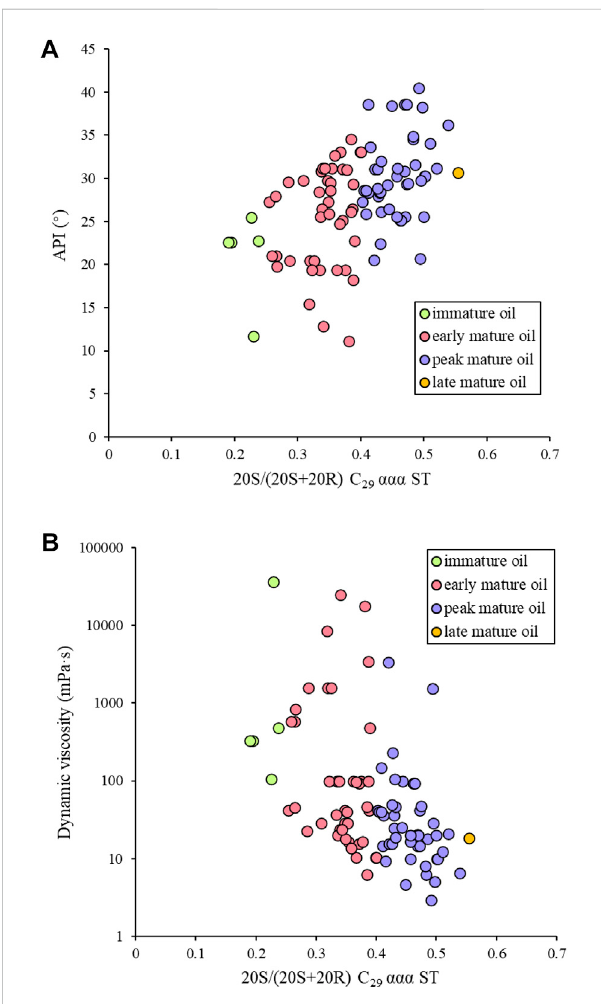
FIGURE 11 Scatter plots of the 20S/(20S+20R) C 29 ααα ST against API gravity (A) , dynamic viscosity (B)